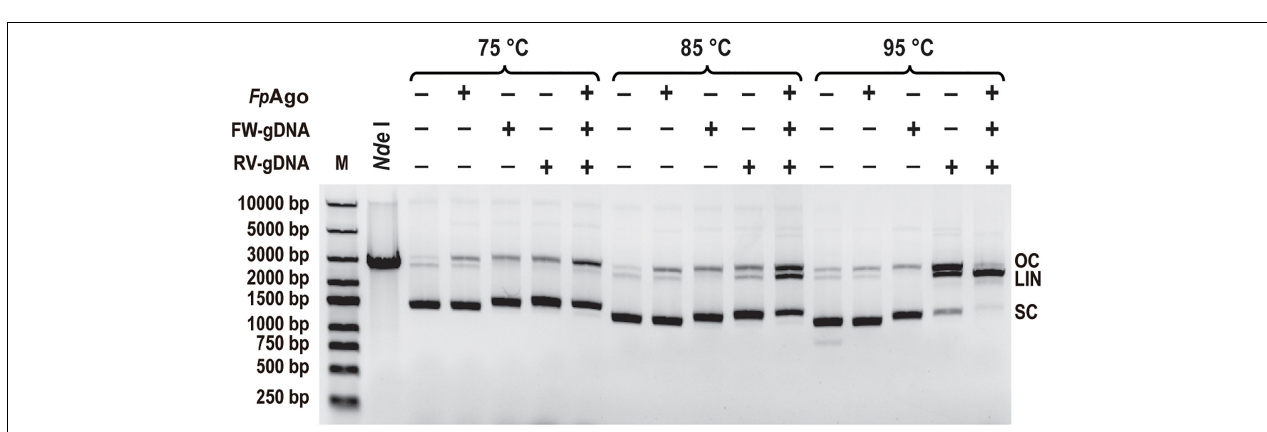
FIGURE 6 | The PAZ domain comparison of the F pAgo with Pf Ago and Mj Ago via homology modeling. (A) The comparison of the Fp Ago (green) with apo Pf Ago (gray). (B) The comparison of the Fp Ago (green) with Mj Ago binary complex (gray) carrying a guide (blue). Only the last three nucleotides locating in the 3 (cid:48) -end of the guide strand were shown. A special loop employed by Fp Ago is highlighted in red.